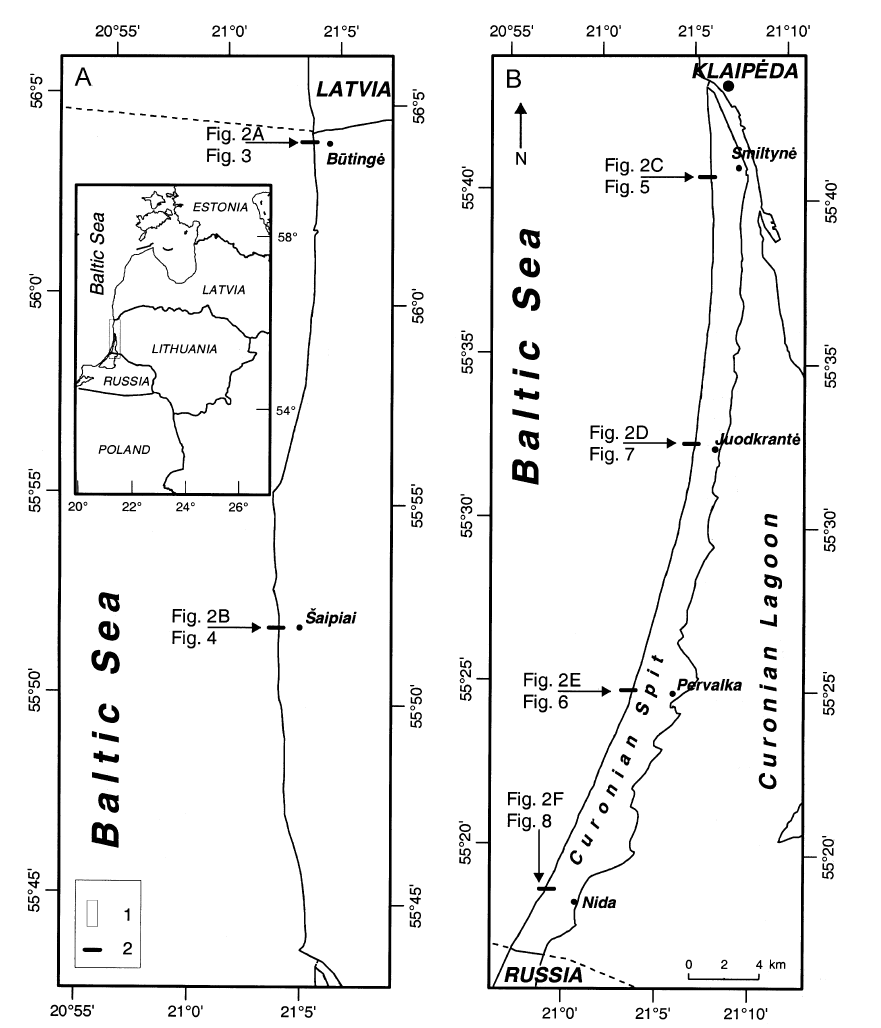
Fig. 1. Location map. 1, study area; 2, sites of measurements. A , mainland coast; B , Curonian Spit coast. The arrows show wind speed measuring and places of the cross section